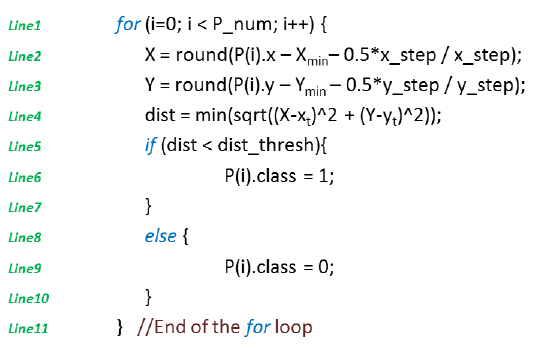
Figure 3: Pseudocode of the algorithm for assigning tree class labels to the points